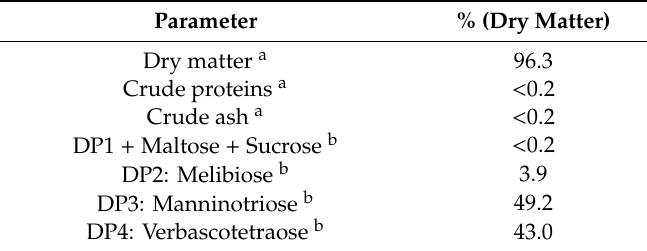
Table 1. Chemical composition of AlphaGOS ®